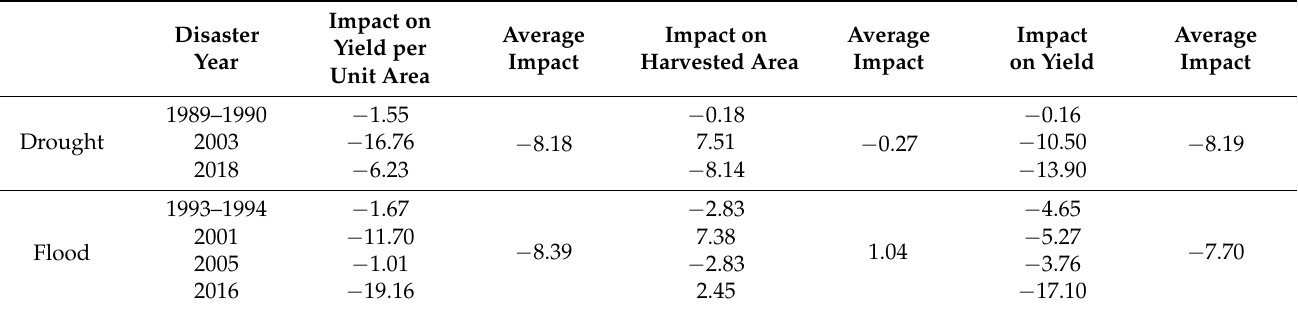
Table 5. Effects of droughts and floods on yield per unit area, harvested area, and yield of barley in France (unit: %).